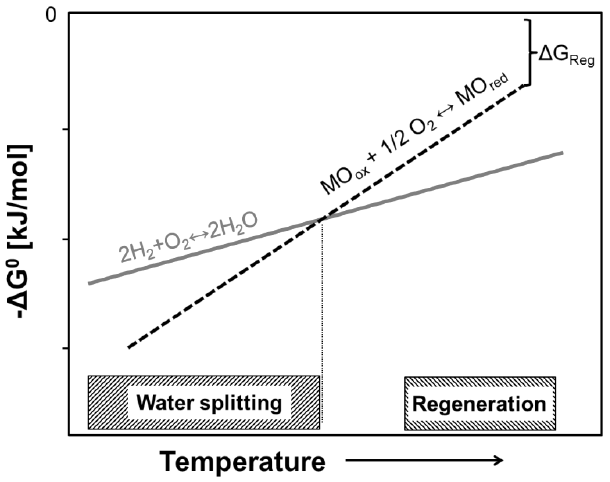
O 2 ↔ MO red compared to H 2 /H 2 O equilibrium [108]. 2 𝑂 (cid:2870) ↔ 𝑀𝑂 (cid:3045)(cid:3032)(cid:3031) compared to H2/H2O equilibrium [108]. (cid:2870)